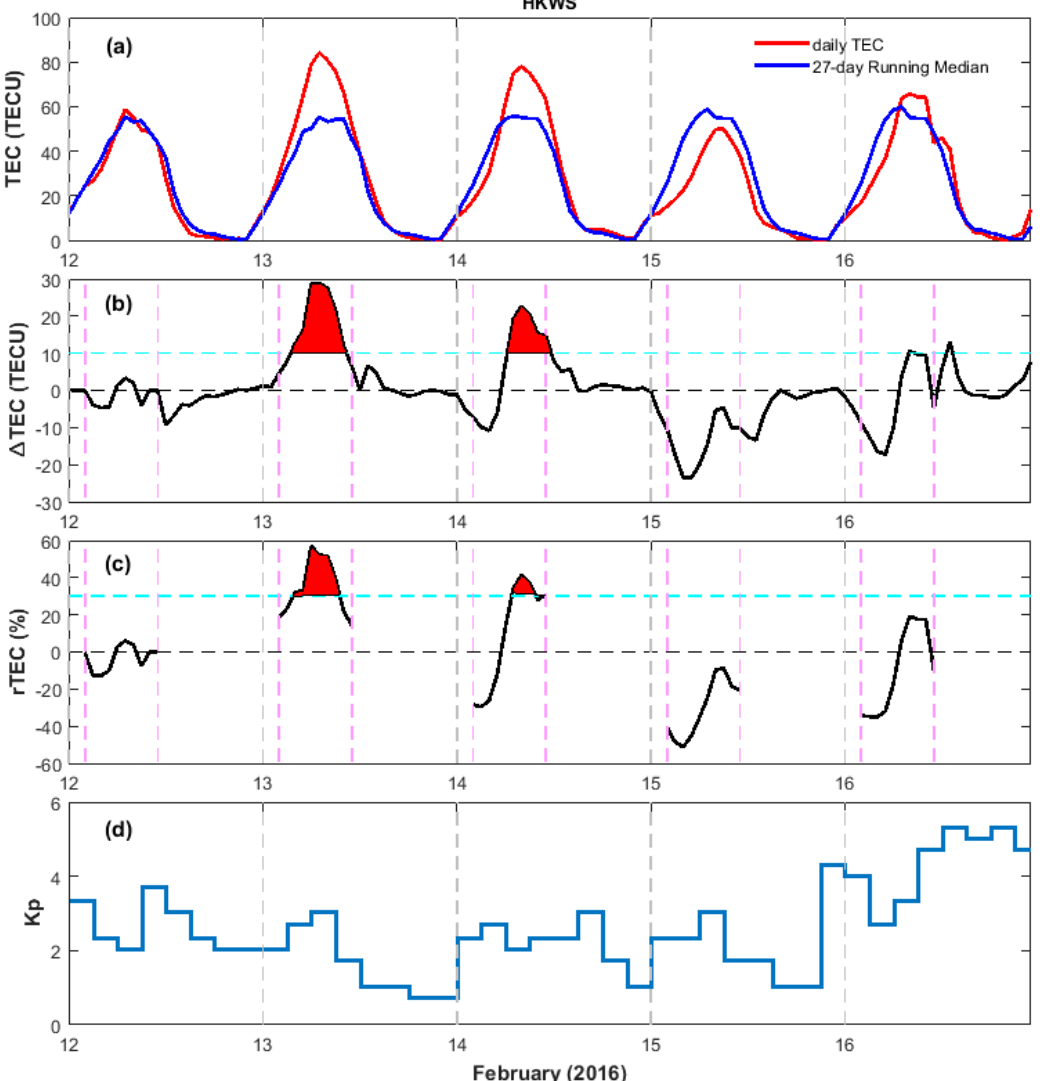
Figure 4. ( a ) Daily TEC (red) variation for 12–16 February 2016 and 27-day running median (blue), ( b ) absolute TEC deviation with the red shaded portions showing where the deviation is above 10 TECU, ( c ) relative TEC deviation with the red shaded portions showing where the deviation is above 30%, and ( d ) the Kp index variation. The grey vertical dashed lines separate the end of one day from the beginning of another day while the magenta vertical dashed lines show the daytime interval of 0900–1800 LT.